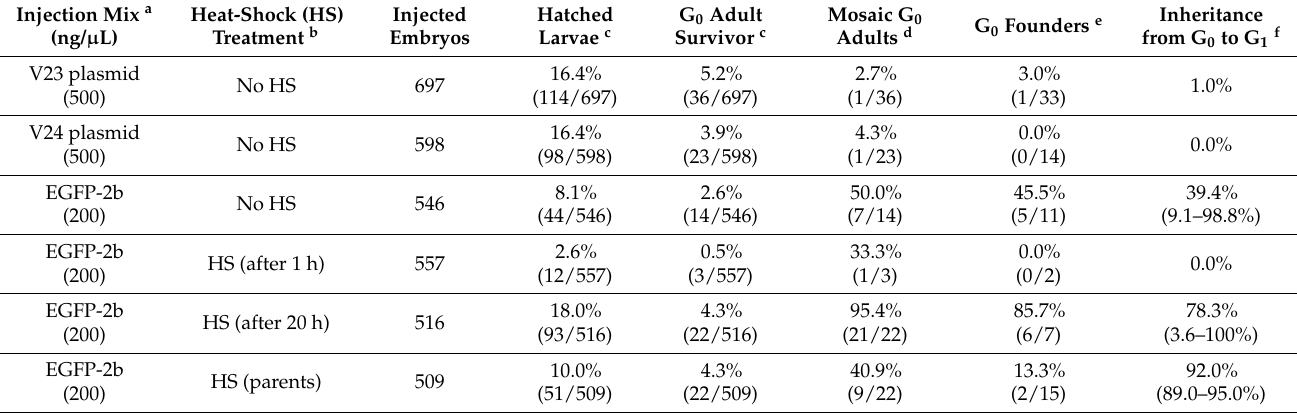
Table 1. Mutagenesis efficiencies targeting EGFP using the Cas9-expressing line M7m1 and different heat-shock conditions. Injection Mix